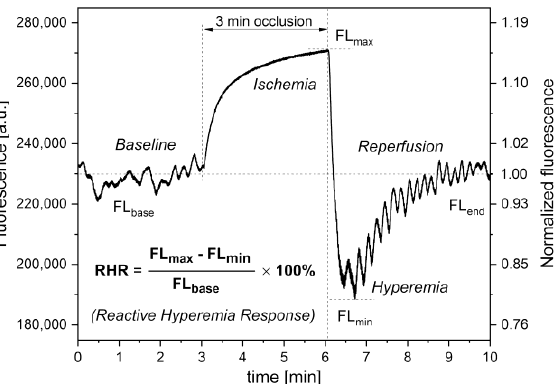
Figure 3. Exemplary FMSF trace recorded for an athlete (male, 40 years); definition of the RHR pa- rameter [43]. Reproduced from: Katarzynska, J.; Zielinski, J.; Marcinek, A.; Gebicki, J. New Ap- proach to Non-Invasive Assessment of Vascular Circulation Based on the Response to Transient